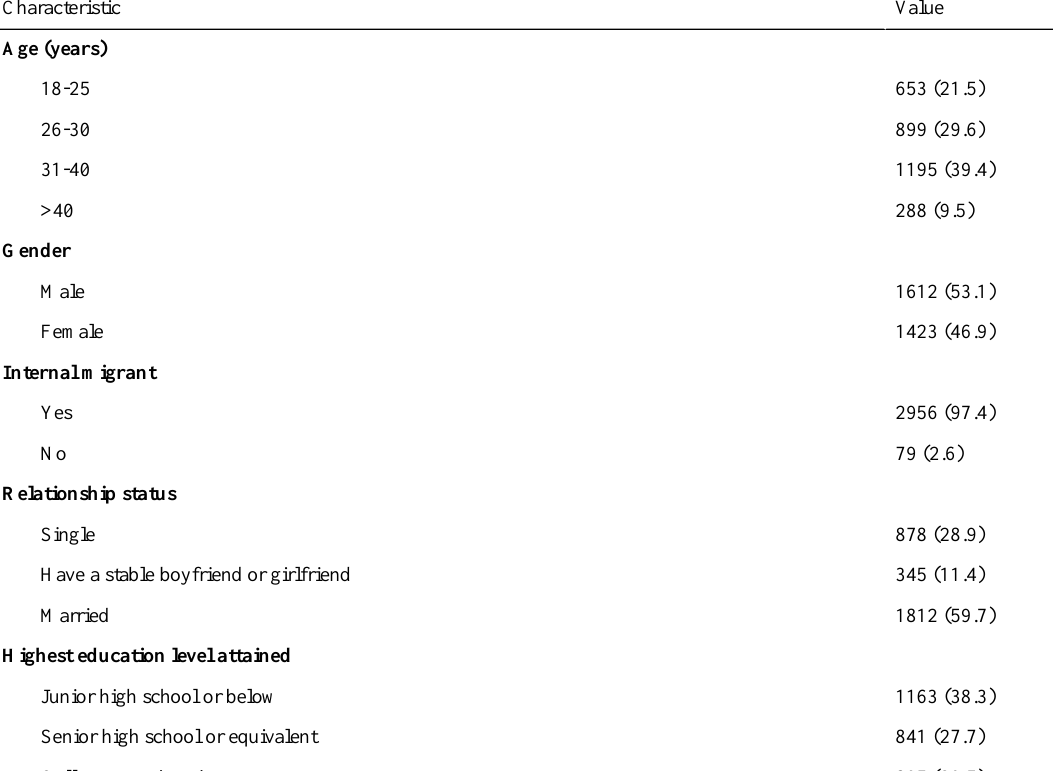
Table 1. Background characteristics of the participants (N=3035), n